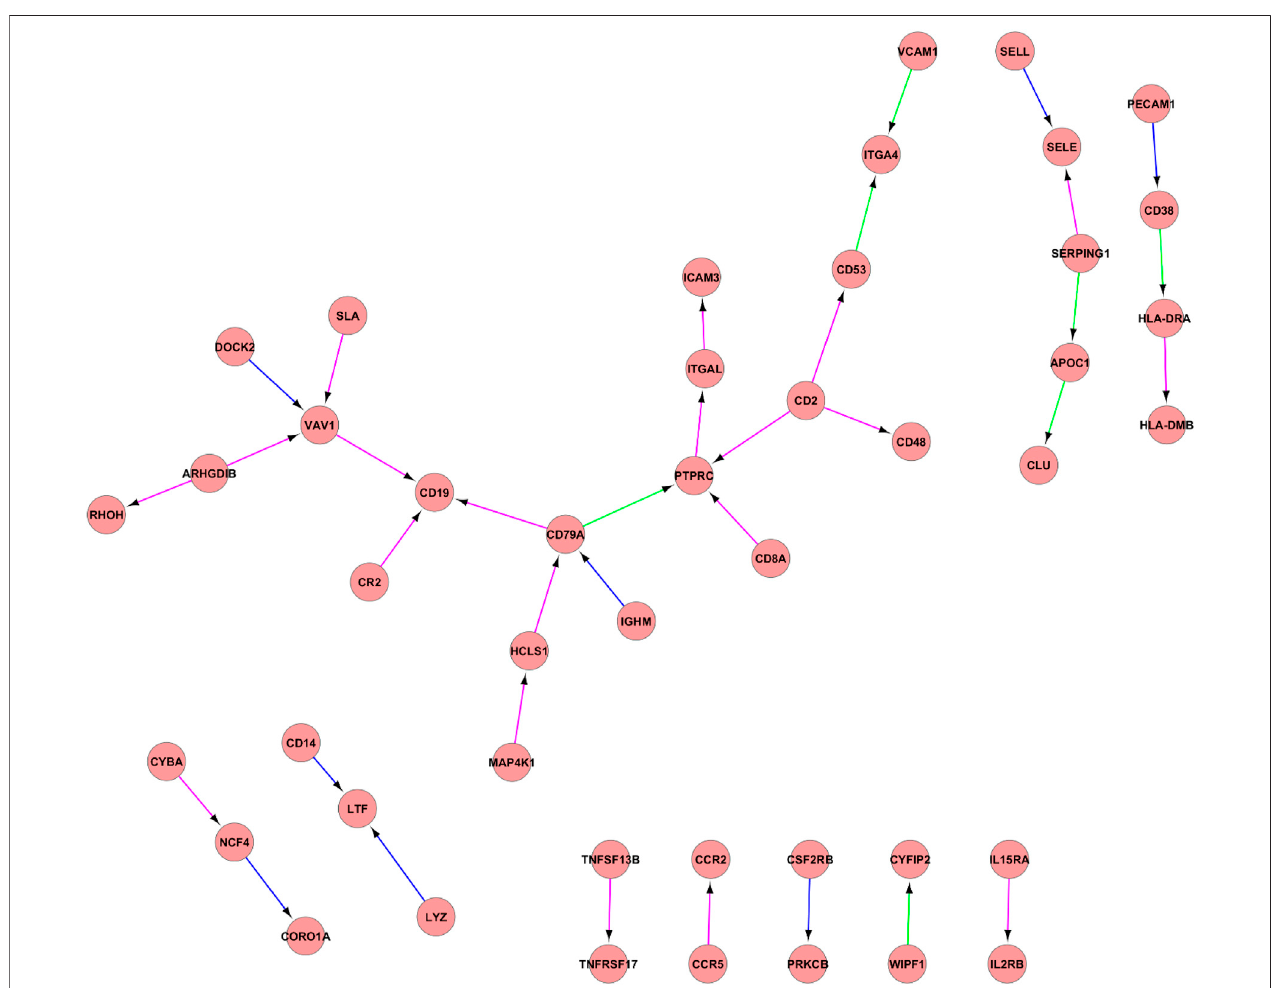
FIGURE 2 | PPI network between IC3_2, IC3_3, and IC3_4. PPI network between IC3_2, IC3_3, and IC3_4. Proteins are illustrated with circles and directed interactions are illustrated with edges. Color of the edges represents the type of experiments used in HPRD database: blue — in vitro , red — in vivo , green — Y2H. This representation was obtained using Cytoscape software according to the HPRD